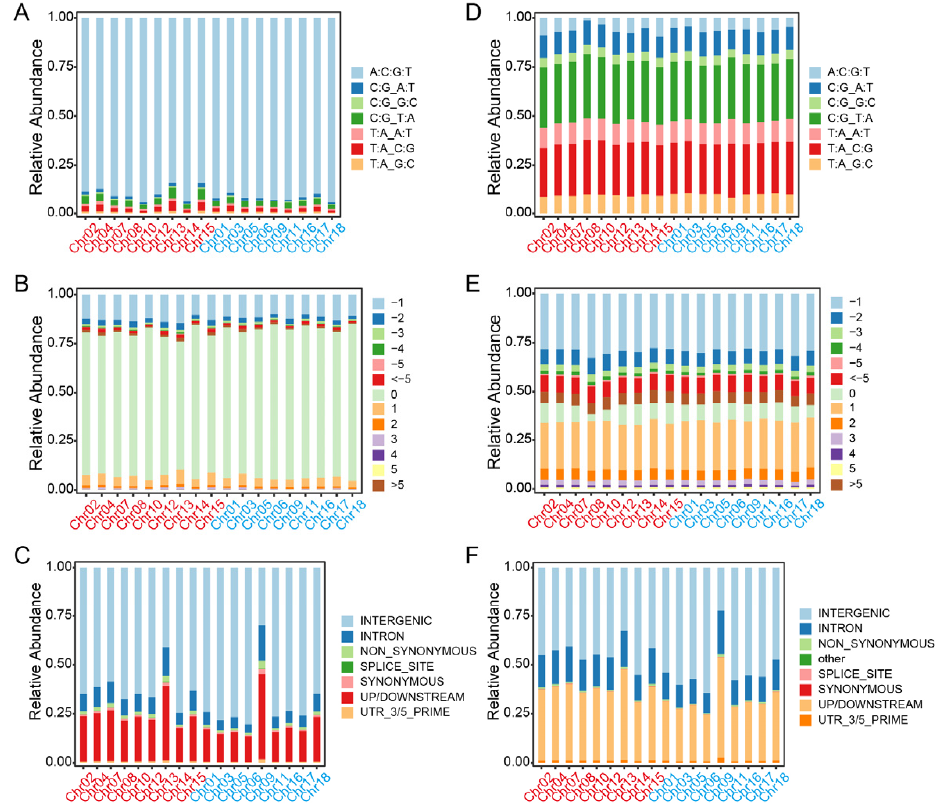
Figure 6. Stacked bar charts of the pairwise SNPs and INDELs in Longli-4 and CA3-1. ( A , D ) Percentages of the seven SNP groups on each chromosome in Longli-4 ( A ) and CA3-1 ( D ). The group of ‘A:C:G:T’ in ( A ) shows the relative abundance of SNPs (2,004,623) with the same nucleotide bases in Longli-4 and the reference line as that in Figure 5A, and the other six groups are classified based on transitions and transversions. The same category method is also used in ( D ) for CA3-1. ( B , E ) Percentages of the 13 INDEL groups on each chromosome in Longli-4 ( B ) and CA3-1 ( E ). The group of ‘0’ in ( B ) represents the relative abundance of INDELs (302,360) with the same genotypes in Longli-4 and the reference line as that in Figure 5B, and the other twelve groups are classified based on the length of insertions and deletions. The same groups are also used in ( E ) for CA3-1. ( C , F ) SNPs ( C ) and INDELs ( F ) are classified into seven groups based on annotation information, and relative abundance values of all groups on each chromosome are shown as a stacked bar. The chromosomes from the A and B sub-genomes of quinoa are shown as those in Figure